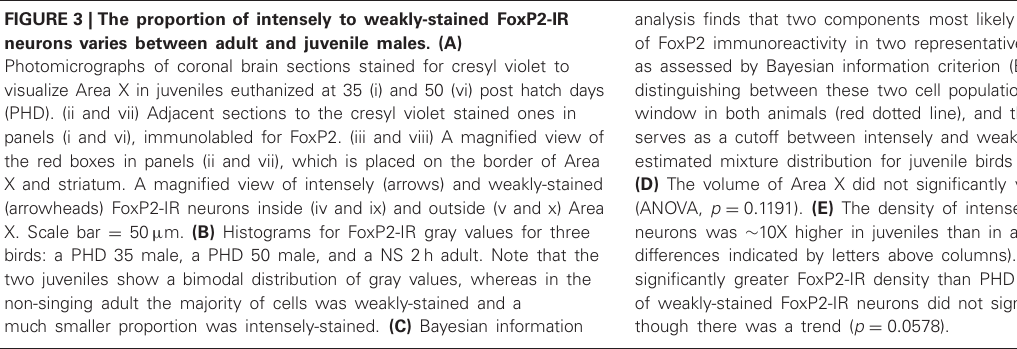
FIGURE 3 | The proportion of intensely to weakly-stained FoxP2-IR neurons varies between adult and juvenile males. (A) Photomicrographs of coronal brain sections stained for cresyl violet to visualize Area X in juveniles euthanized at 35 (i) and 50 (vi) post hatch days (PHD). (ii and vii) Adjacent sections to the cresyl violet stained ones in panels (i and vi), immunolabled for FoxP2. (iii and viii) A magnified view of the red boxes in panels (ii and vii), which is placed on the border of Area X and striatum. A magnified view of intensely (arrows) and weakly-stained (arrowheads) FoxP2-IR neurons inside (iv and ix) and outside (v and x) Area X. Scale bar = 50 µ m. (B) Histograms for FoxP2-IR gray values for three birds: a PHD 35 male, a PHD 50 male, and a NS 2h adult. Note that the two juveniles show a bimodal distribution of gray values, whereas in the non-singing adult the majority of cells was weakly-stained and a much smaller proportion was intensely-stained. (C) Bayesian information